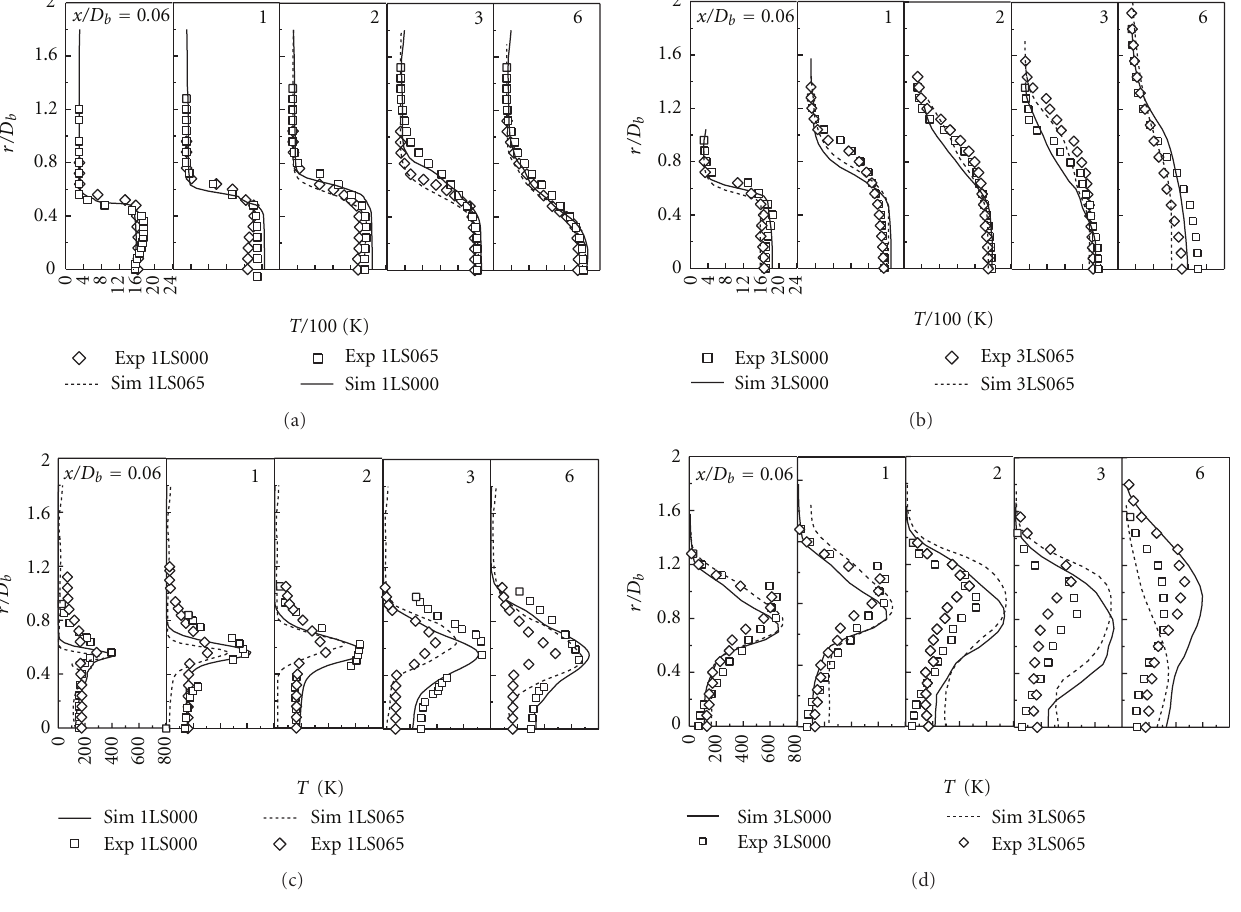
Figure 7: Comparisons between measurements and simulations of the time mean (a and b) and rms (c and d) radial temperature distributions throughout the wake for the single- and the three-disk burner set ups at swirl intensities of 0 and